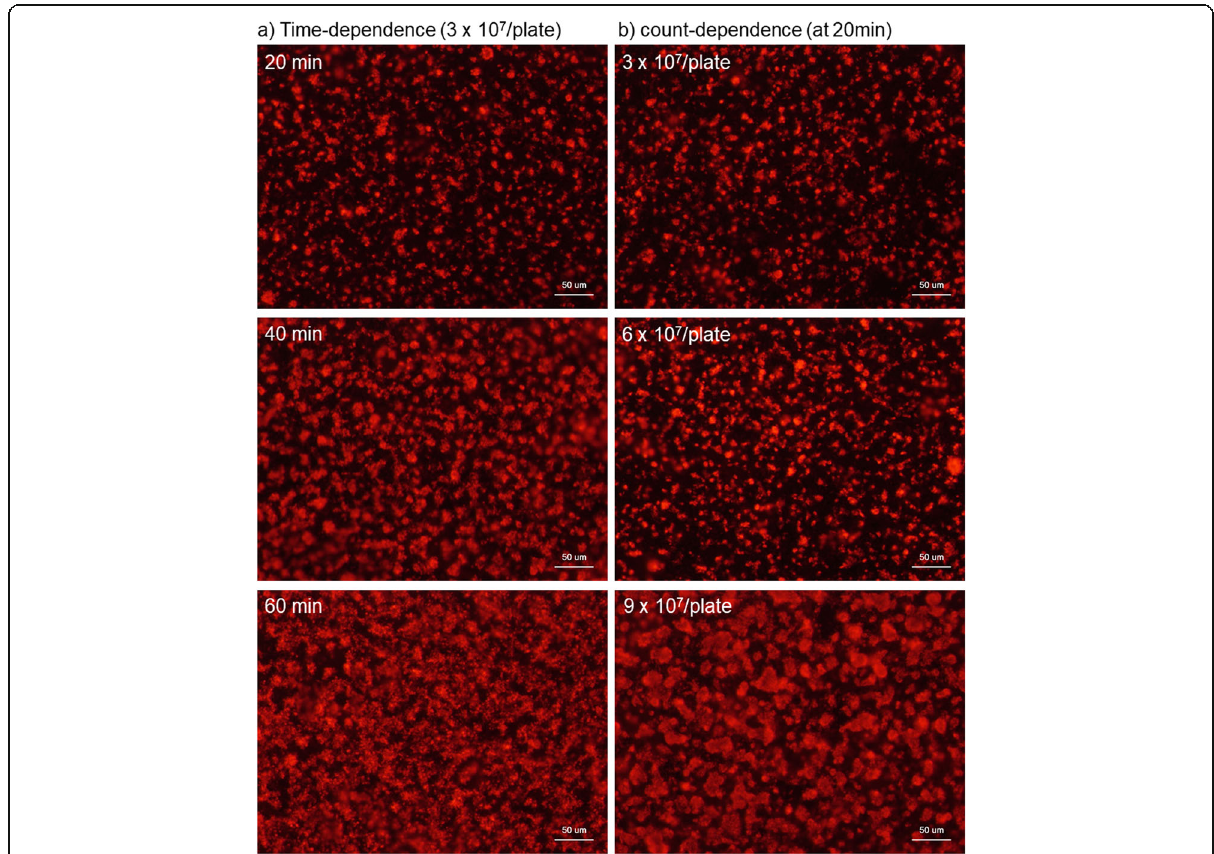
Fig. 5 Time- and count-dependent platelet adhesion on CaP-blasted cp-Ti plates. a Platelets in the form of PRP was inoculated at the fixed count of 3 × 10 7 /plate and incubated at ambient temperature for 20, 40, and 60 min. b Platelets in the form of PRP was inoculated at counts of 3 ×, 6 ×, and 9 × 10 7 /plate and incubated for the fixed period of time, 20 min. Cytoskeletal actin filaments were stained with phalloidin